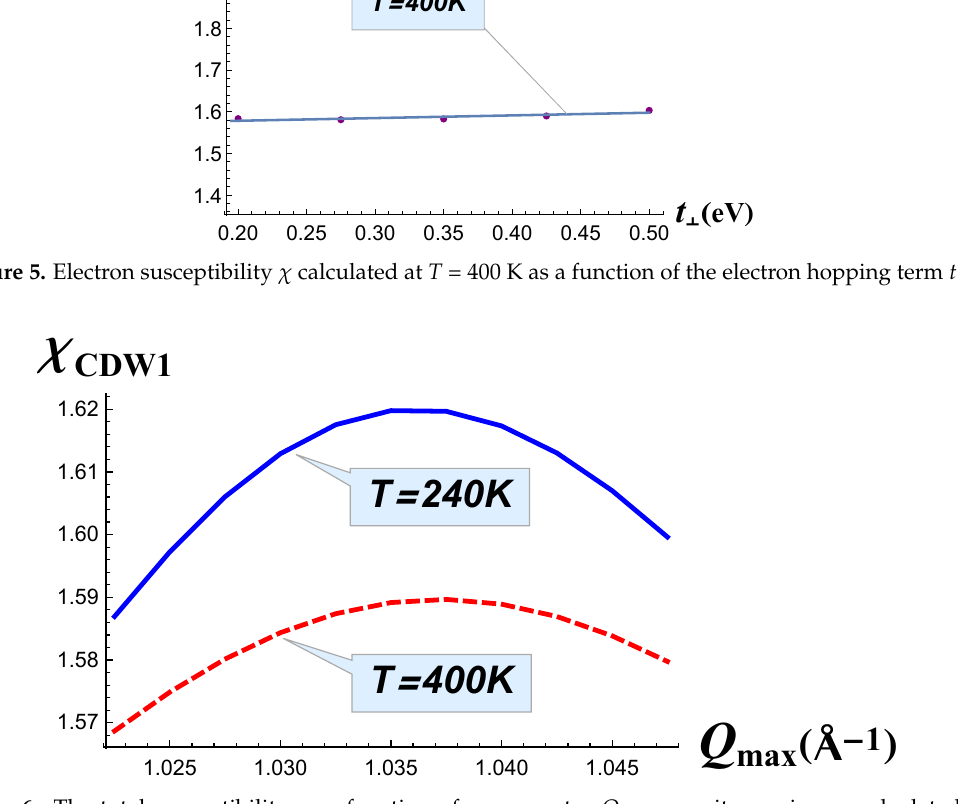
Figure 6. The total susceptibility as a function of wave vector Q max near its maximum calculated at T = 240 K (solid blue line) and at T = 400 K (dashed red